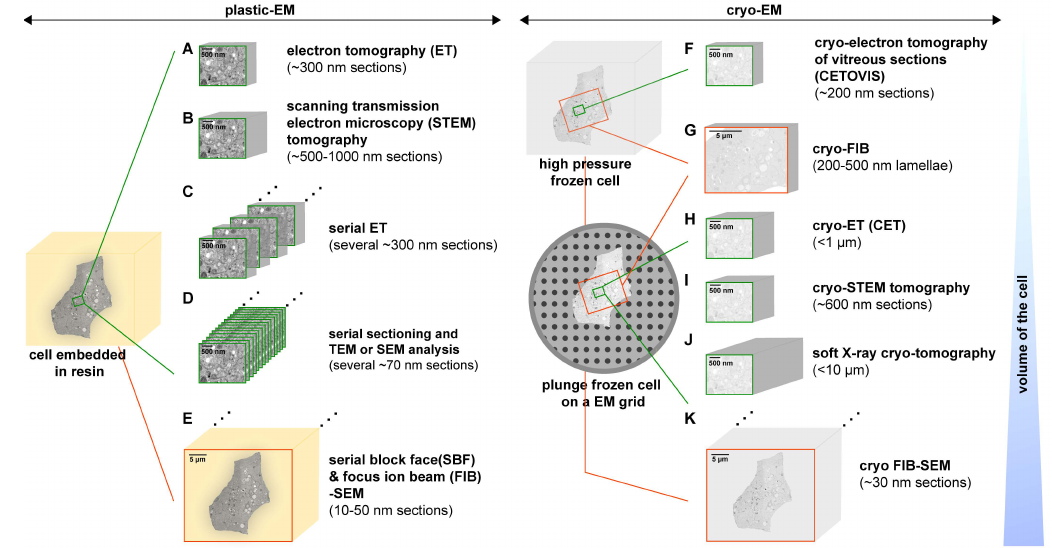
Figure 4. Overview of the 3D-EM methods that can be used to analyze the architecture of virus-infected cells by means of plastic-EM (A-E, on the left) or cryo-EM (F-K, on the right). ( A , B ) Thicker sections of approximately 300 nm and 500–1000 nm of a region of interest (ROI, highlighted in green) can be